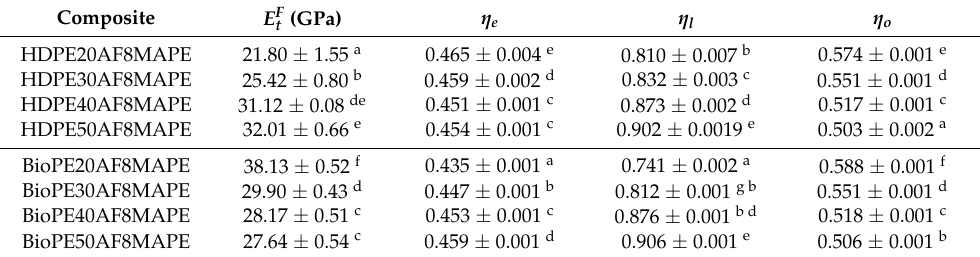
Table 2. Influence of AF content on the intrinsic Young’s modulus ( E F and orientation ( η o ) factors of 8wt.% coupled